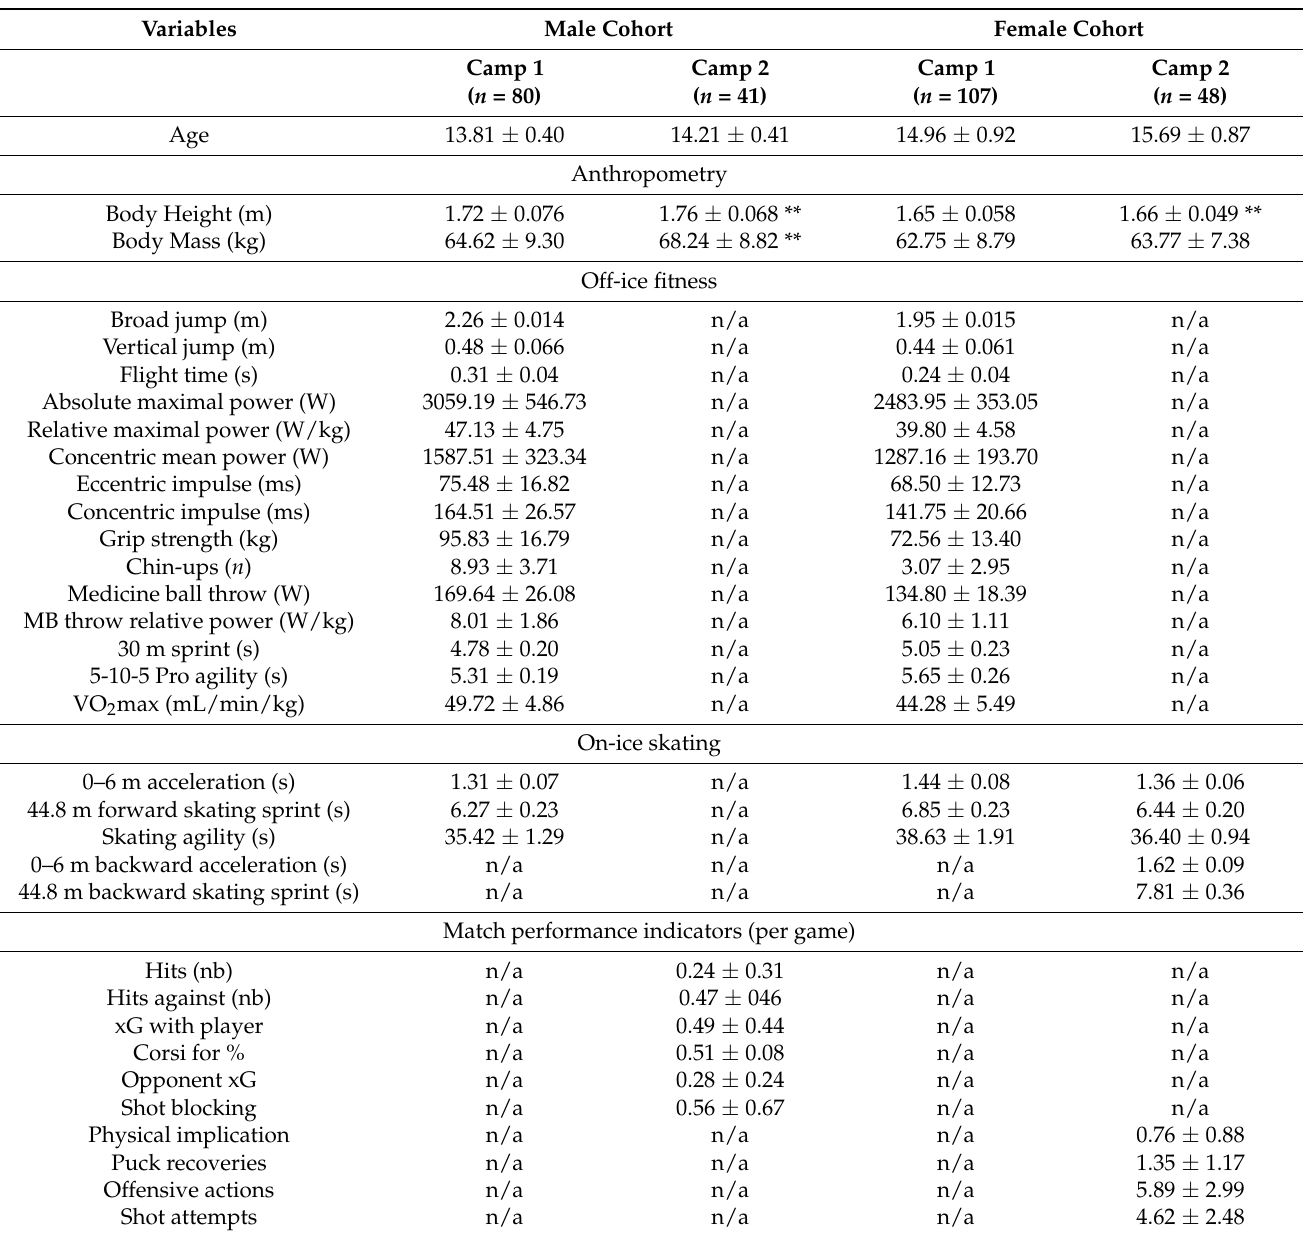
Table 2. Descriptive statistics (Camp 1 and Camp